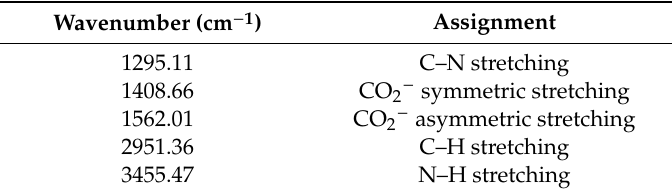
Figure 2. Chemical structure and IR results of polyglutamic acid. Table 1. The main functional groups in polyglutamic acid.